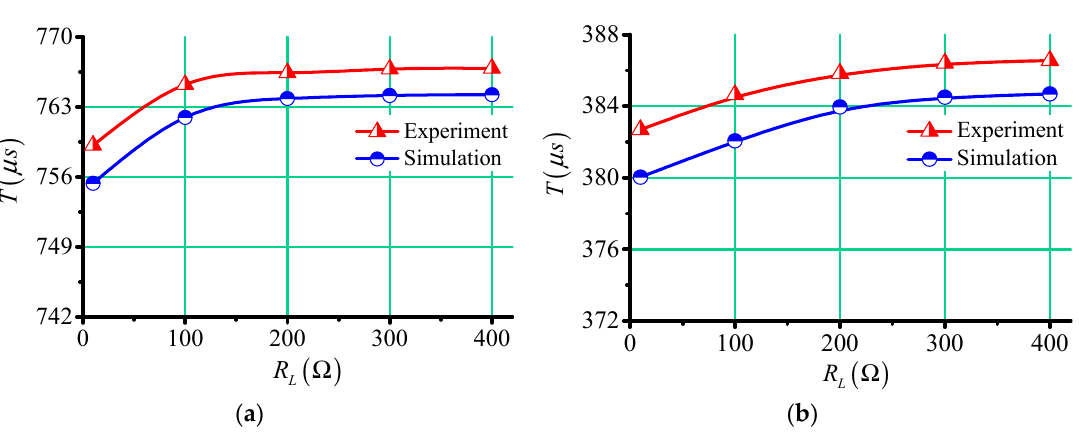
Figure 10. The cycle times of oscillation attenuation waveforms measured in simulations and experiments. ( a ) C 0 + C 1 = 2 µ F , ( b ) C 1 = 0.51 µ F .